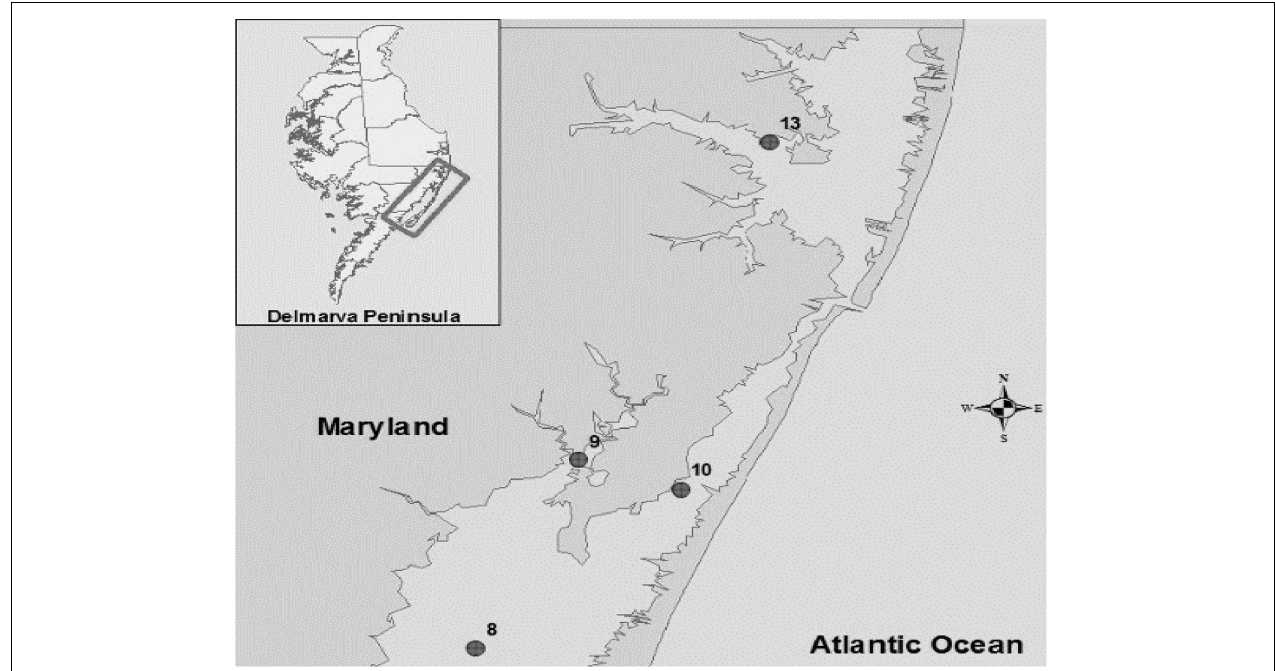
FIGURE 1 | Location of sampling sites in the Maryland Coastal Bays. 8- Chincoteague Bay, 9- Newport Bay, 10- Sinepuxent Bay, 13–St. Martin River. Courtesy of Tracie J. Bishop and Andres G. Morales-Nunez (Rodgers et al., 2014).